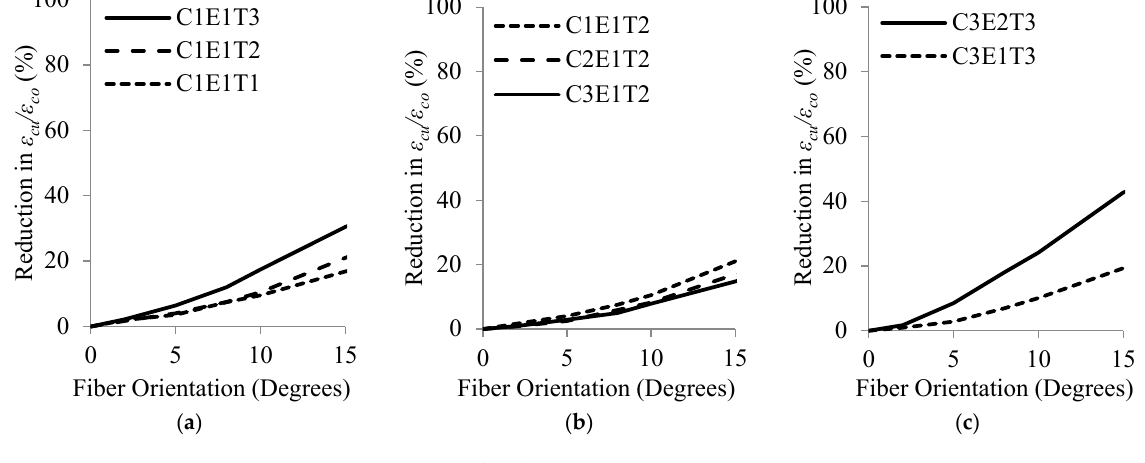
Figure 9. Variations of 𝜀 (cid:3030)(cid:3048)(cid:4593) /𝜀 (cid:3030)(cid:3042)(cid:4593) versus fiber orientation for selected specimens: ( a ) for 𝑡 (cid:3033)(cid:3045)(cid:3043) from 0.2 to 1.0 mm, ( b ) for 𝑓 (cid:3030)(cid:3042)(cid:4593) from 20 to 50 MPa and ( c ) for 𝐸 (cid:3033)(cid:3045)(cid:3043) of 50 and 200 GPa. Table 11. Reduction in 𝜀 (cid:3030)(cid:3048)(cid:4593) /𝜀 (cid:3030)(cid:3042)(cid:4593) and 𝐸 (cid:3047) due to deviation in fiber orientation for different values of 𝐸 (cid:3033)(cid:3045)(cid:3043) , 𝑡 (cid:3033)(cid:3045)(cid:3043) and 𝑓 (cid:3030)(cid:3042)(cid:4593) . Deviation in Fiber Orientation from 0° to 15° Parameter Reduction in 𝑬 𝒕 (%) Reduction in 𝜺 𝒄𝒖 (cid:4593) /𝜺 𝒄𝒐 (cid:4593) (%)